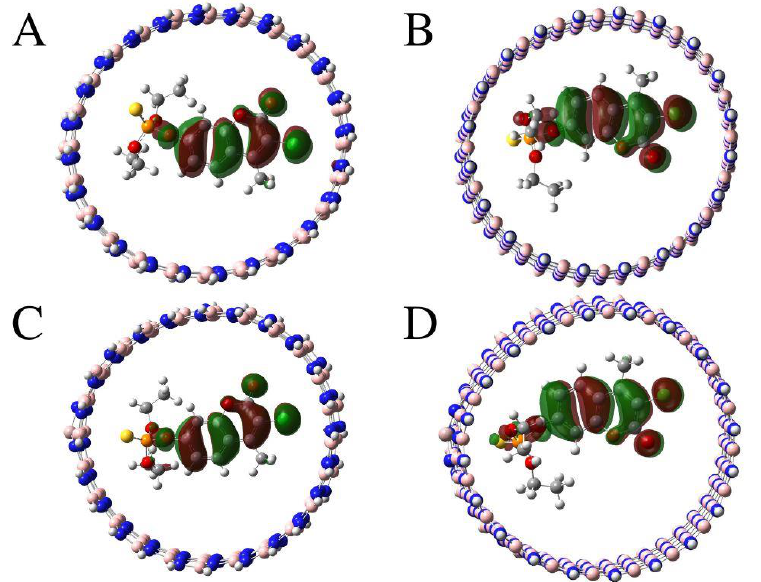
Figure 6. The HOMO diagrams of ( A ) BNNT(12,12) + cou, ( B ) BNNT(20,0) + cou, ( C ) Al-BNNT(12,12) + cou, and ( D ) Al-BNNT(20,0) + cou.